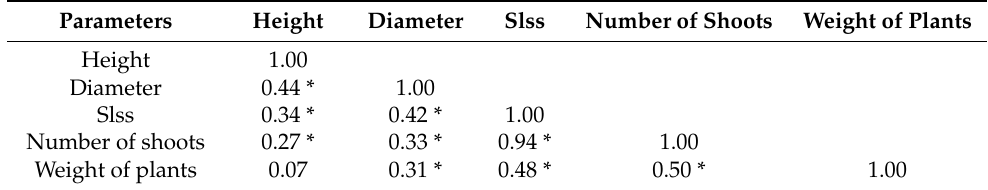
Table 3. The correlations between the studied parameters of growth (averages for the three years